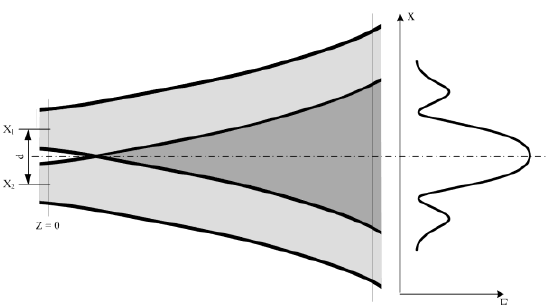
Fig. 1. Superposition of Gaussian beams and distribution of electric field at coordinate Lz  in far field region (shown schematically).